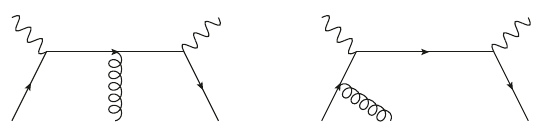
Figure 1 . A quark-antiquark-gluon matrix element of the product of electromagnetic